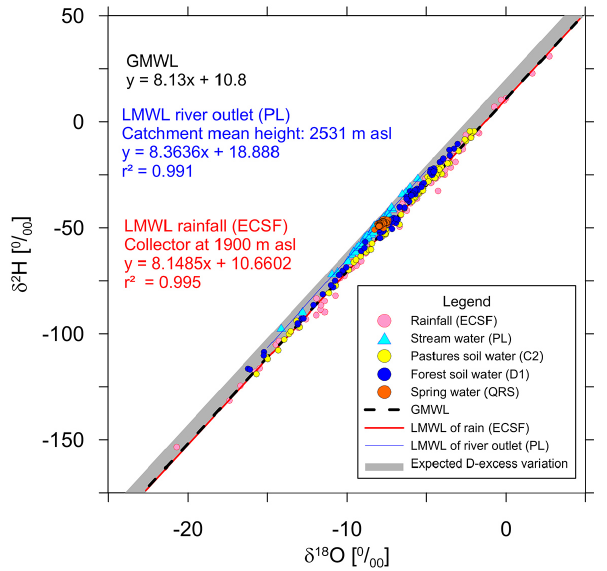
Fig. 3. Shaded area depicts the expected variation range of the local meteorological water line of rainfall (LMWL) considering the alti- tudinal range of the catchment (1725–3150ma.s.l.) and estimated d -excess gradient. Symbols in colors depict weekly values of some of the catchment’s waters. Acronyms are defined in Table